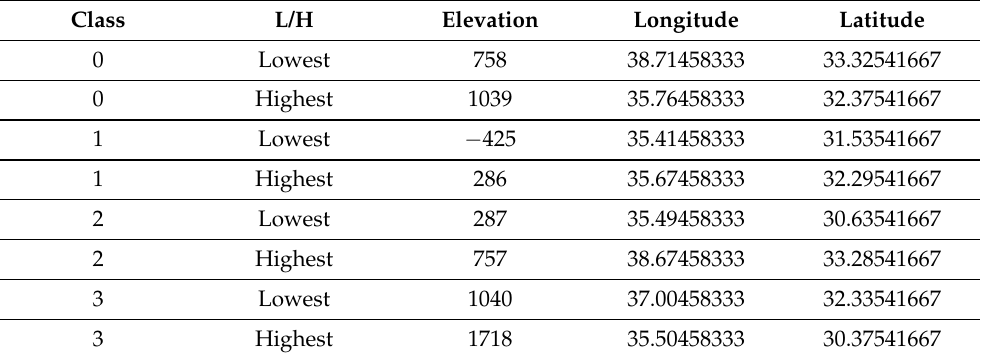
Table 2. Elevation—lowest and highest value–longitude and latitude samples in each cluster with K =